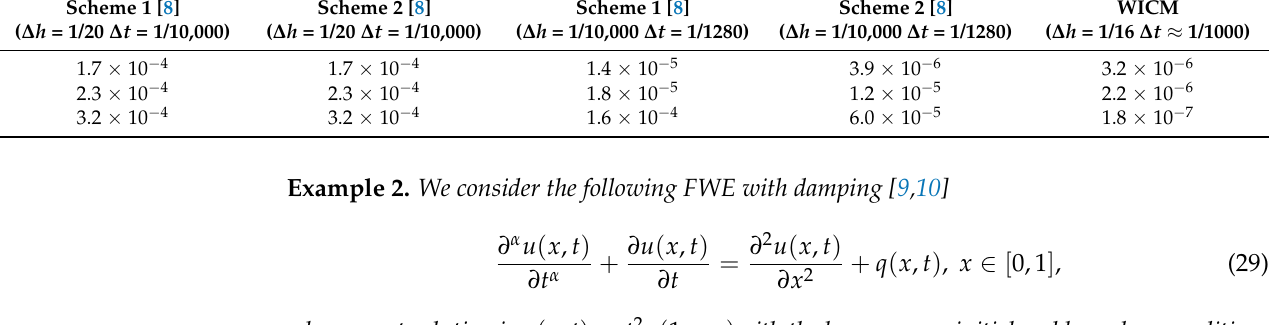
Figure 2. The comparisons of exact and numerical solutions with ∆ h = 1/16 and ∆ t = 1/1024 of Example 1 with α = 1.2, 1.4, 1.6, 1.8, respectively. Table 1. Error norms of numerical solutions at t =1 for Example 1 with different α .